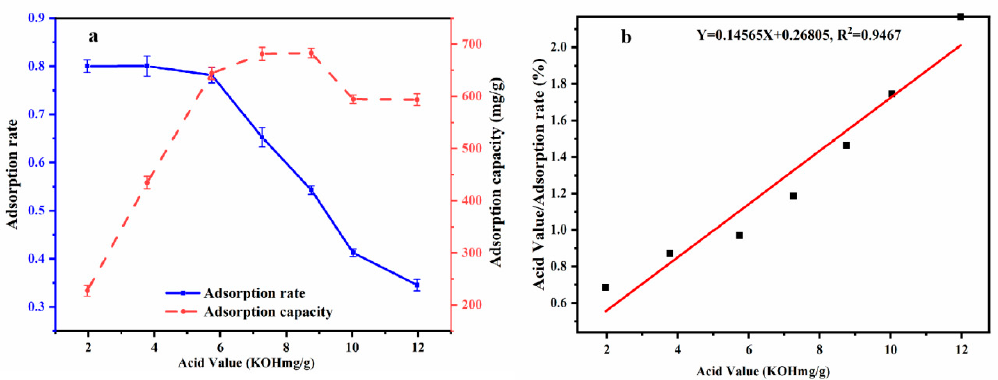
Figure 2. Different acid values on adsorption rate and adsorption capacity ( a ); Adsorption isotherm of acid value at equilibrium concentration Langmuir equation (Xe/q) ( b ).